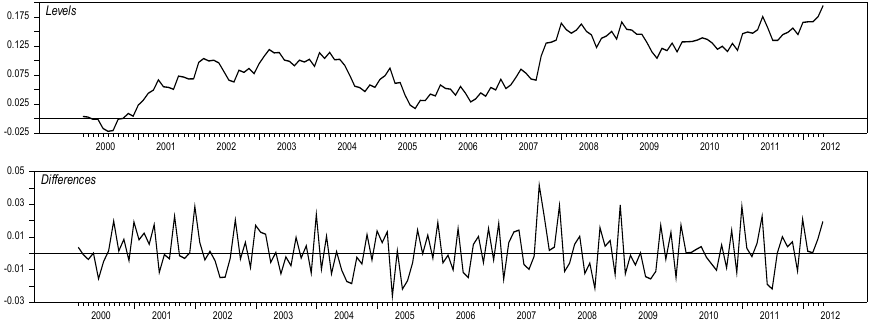
Figure 10. Slovenian food and beverages price index I ( 1 ) . Data vector January 2000 to May 2012 (Great Depression).